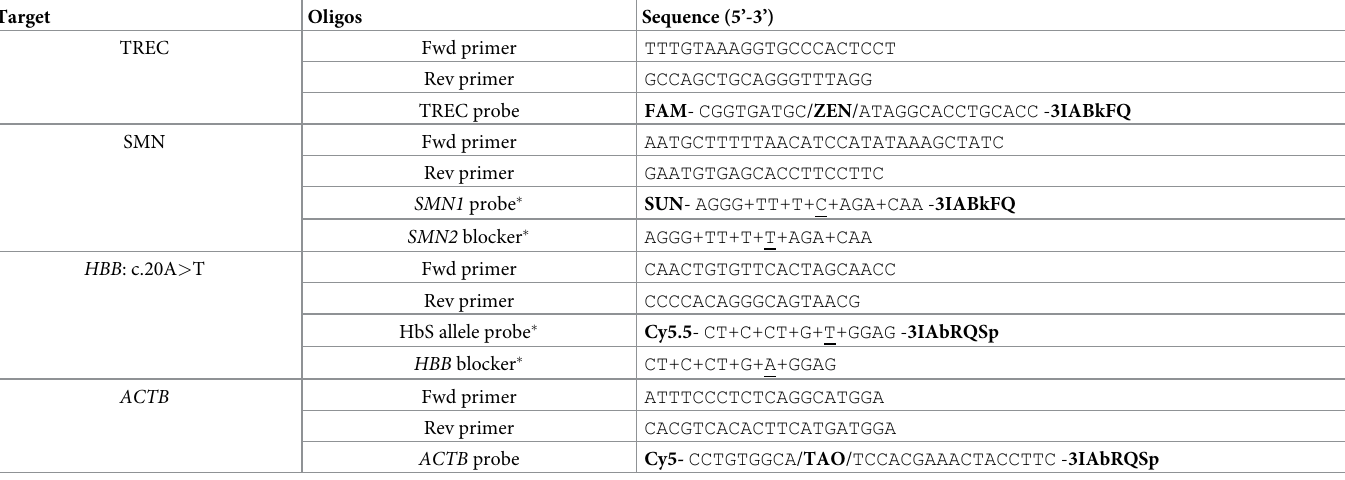
Table 1. Sequences of the primers and probes with their respective fluorophore reporter, quencher and nucleotide modifications used in the qPCR screening assay.